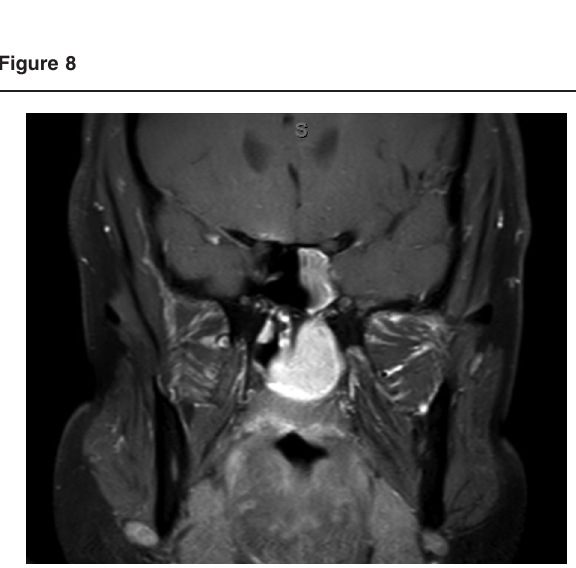
MRI, T1, coronal view shows the mass extending into the left sphenoid sinus and the